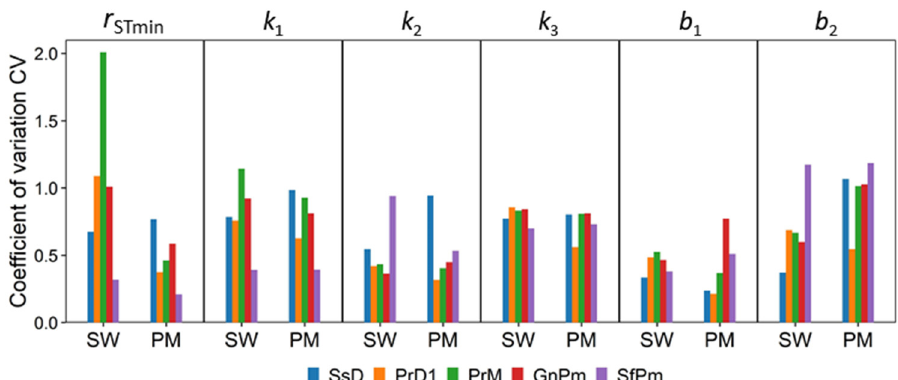
Figure 4. Coefficient of variation of posterior mean values of the parameters estimated in the Shuttleworth–Wallace (SW) and Penman–Monteith (PM) models using the hierarchical Bayesian (HB) approach, calculated from σ θ divided by θ s , mean in Equation (23), indicating the degree of variation in the posterior mean value of the three calibration periods.